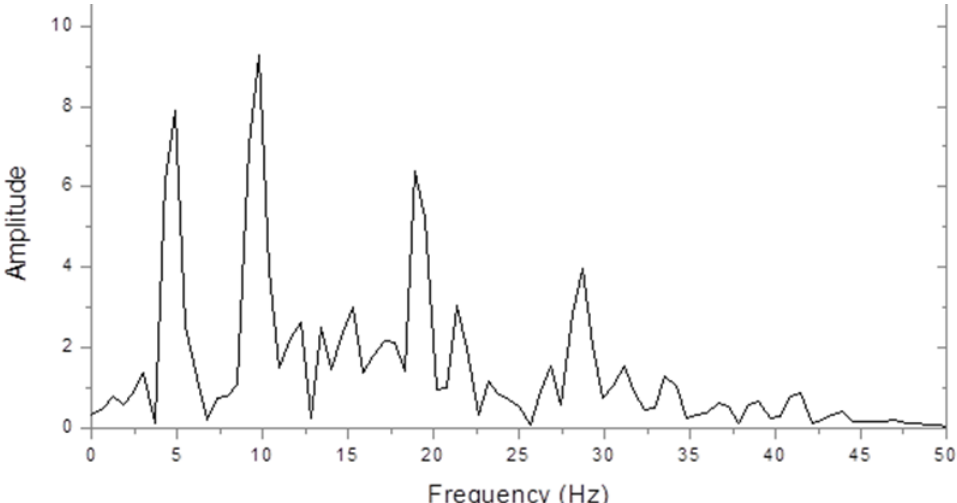
Figure 1. Control steady state visually evoked event-related potentials (VERP) spectrum (microvolts/hertz) in response to chequer board stimulation at 5 Hz.